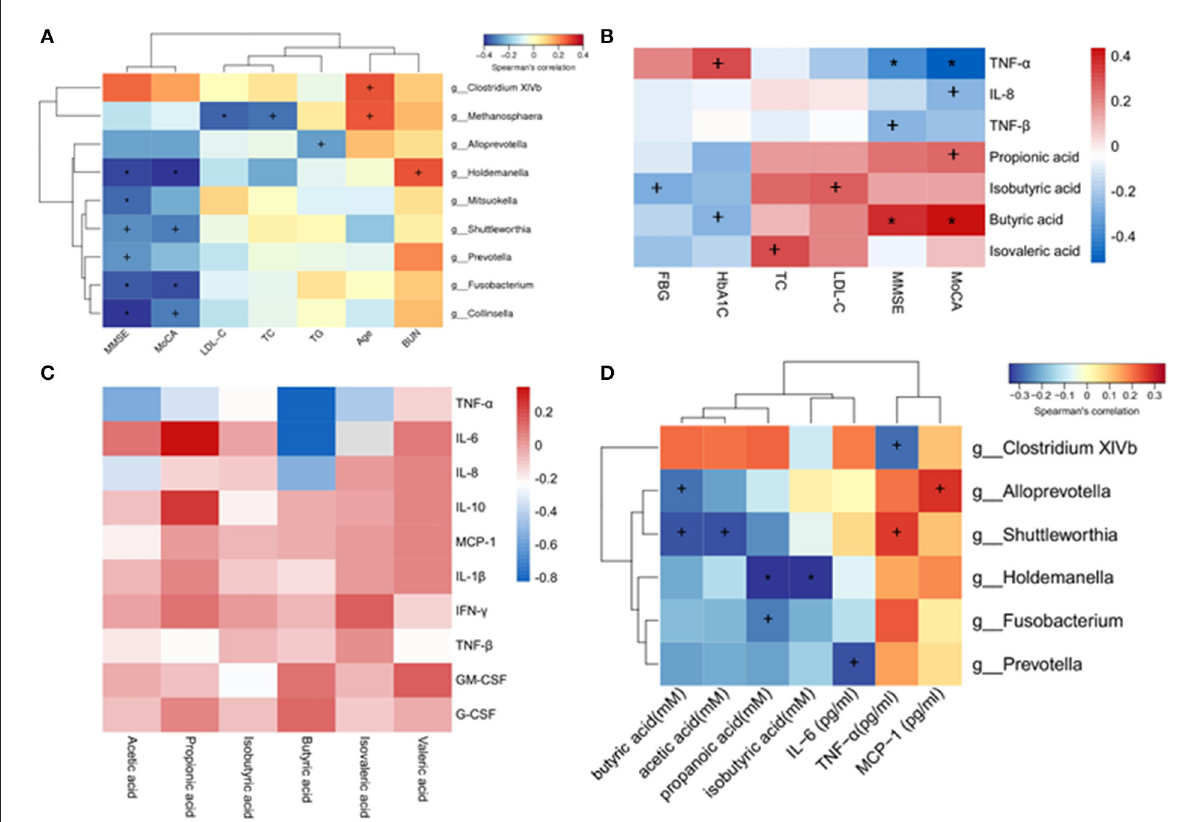
FIGURE5 Heatmaps showing correlations between altered gut microbiota (genus level) and DCI clinical characteristics. (A) Correlations between altered gut microbiota and DCI clinical characteristics. (B) Correlations between plasma levels of SCFAs, inflammatory cytokines and DCI clinical characteristics. (C) Correlations between plasma levels of SCFAs and inflammatory cytokines. (D) Correlations between altered gut microbiota and plasma levels of SCFAs and inflammatory cytokines. + P < 0.05; * P <